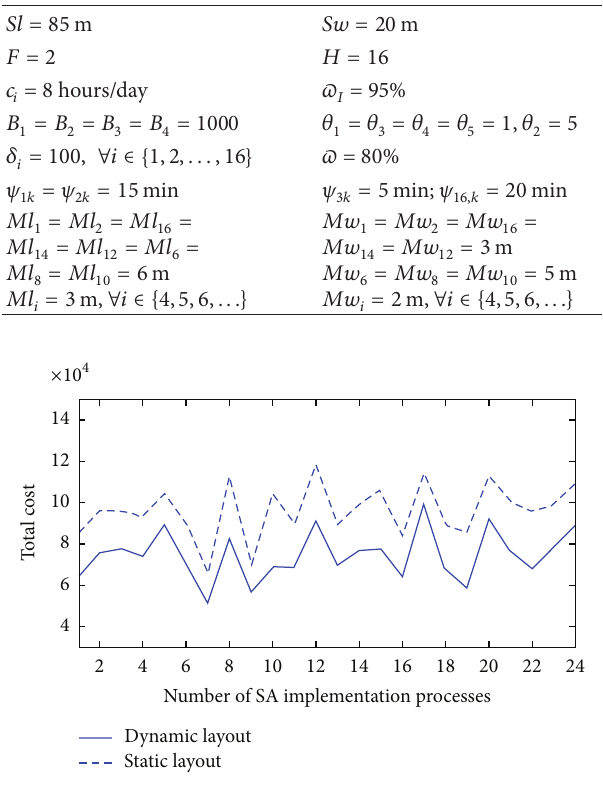
Figure4:Performancecomparisonofthedynamiclayoutversusthe static one ( 𝛿 = 100 , 𝜋 = 1.0